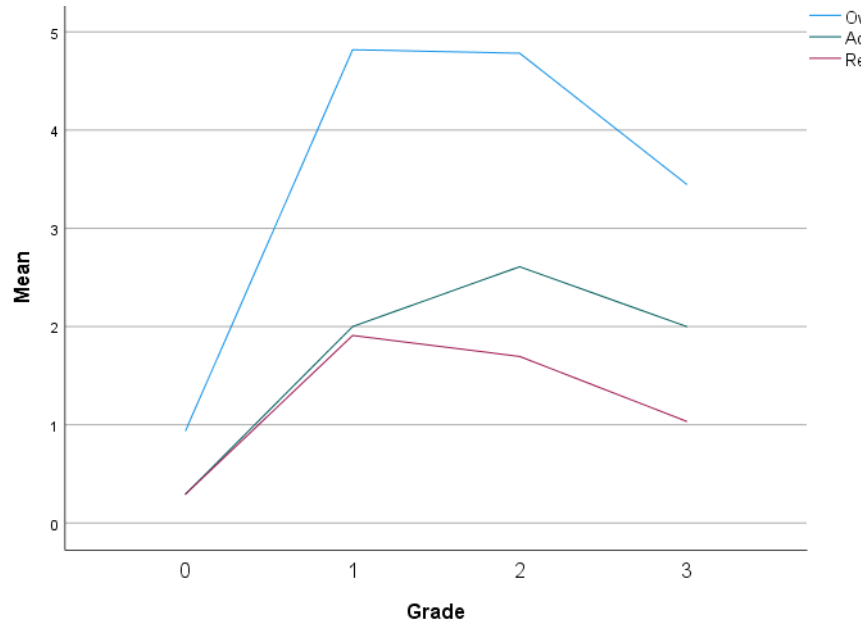
Figure 16. Correlation between the building grade and types of interventions it has